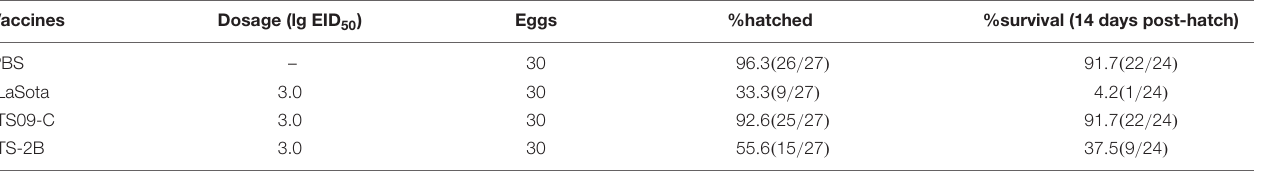
TABLE 3 | Hatchability and survival rates of SPF chickens vaccinated in ovo with different NDV mutants. Vaccines Dosage (lg EID 50